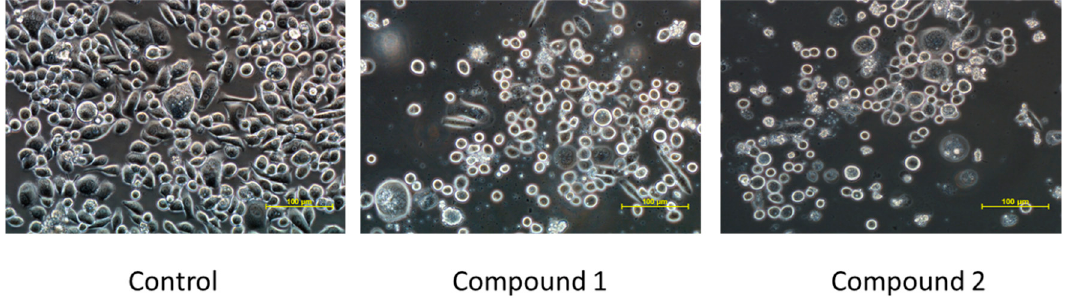
Figure 5. MKN74 cells morphology analyzed under a phase-contrast microscope Nikon Eclipse Ti.